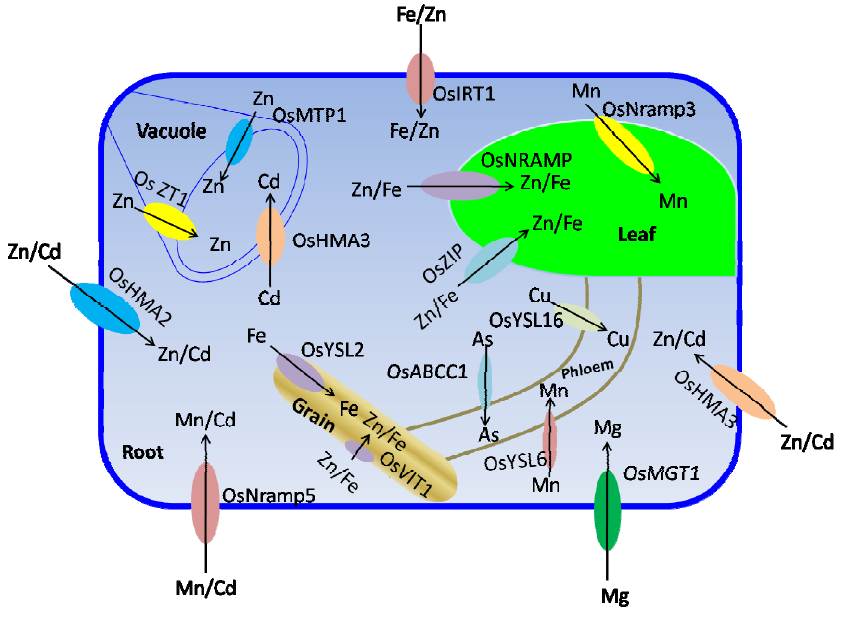
Figure 3. Transition metal transporters implicated for TEs management in